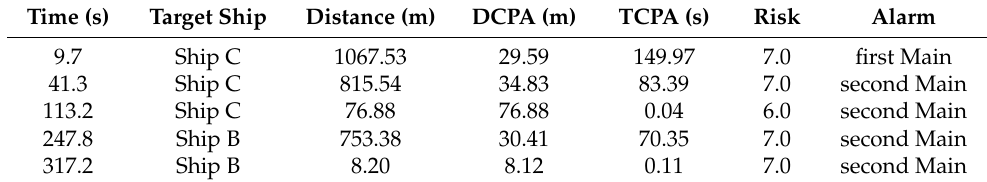
Figure 8. ( a ) Diagrammatic representation of the track of the alarms generated from the results of case 1 and ( b ) graphical representation of the alarms generated on ship D based on the time (from the top, alarms based only on DCPA and TCPA criteria, alarms based only on PARK model risk value criterion, and alarms based on the algorithm). Table 5. Analysis of the situation of alarm generation on ship D in case 1.